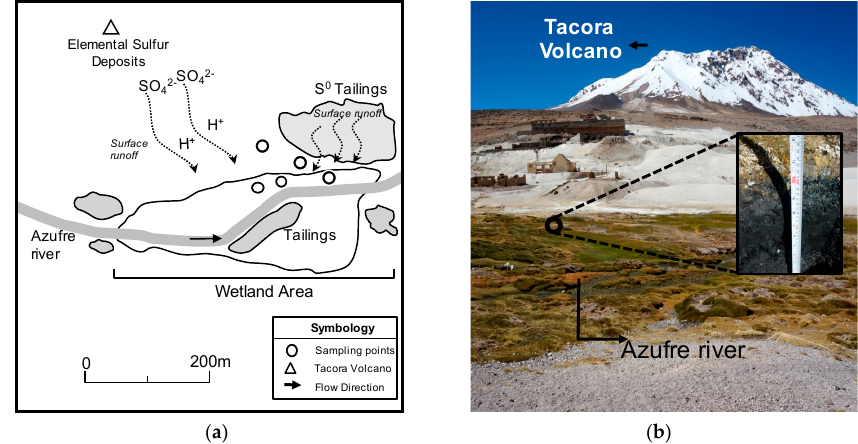
Figure 1. ( a ) Schematic representation of the study site in the Aguas Calientes area, Azufre River sub-basin in northern Chile. ( b ) Photograph of the wetland area with a representative sulfate reduction sediment profile.